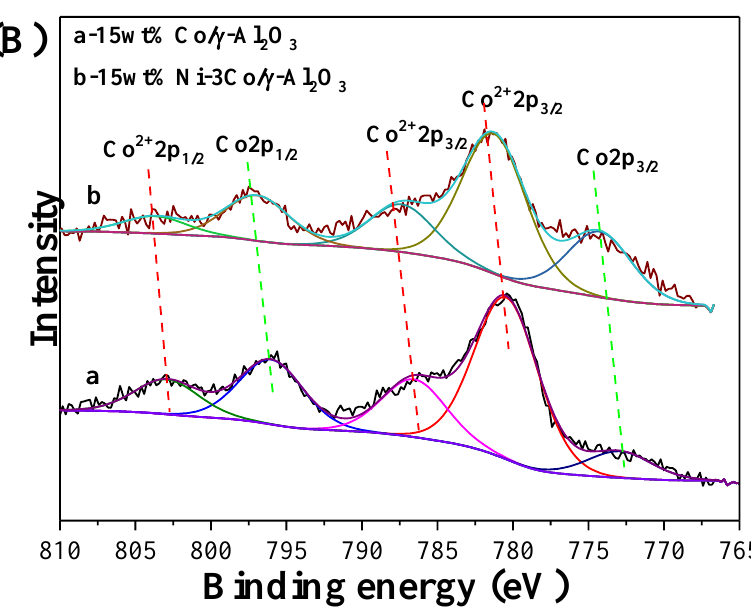
Figure 3. XPS spectra of Ni2p region (i.e., A ) and Co2p region (i.e., B ) for 15 wt%Ni/γ-Al 2 O 3 , 15 wt%Ni–3Co/γ-Al 2 O 3 and 15 wt%Co/γ-Al 2 O 3.